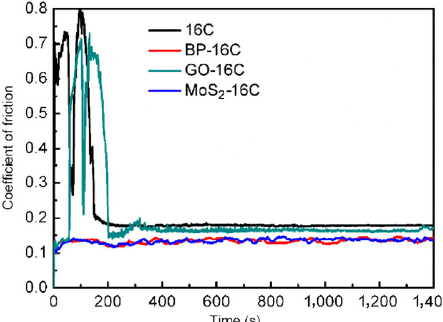
Fig. 20 Compare of coefficients of friction (COF) of three 2D materials lubrication additive at 1